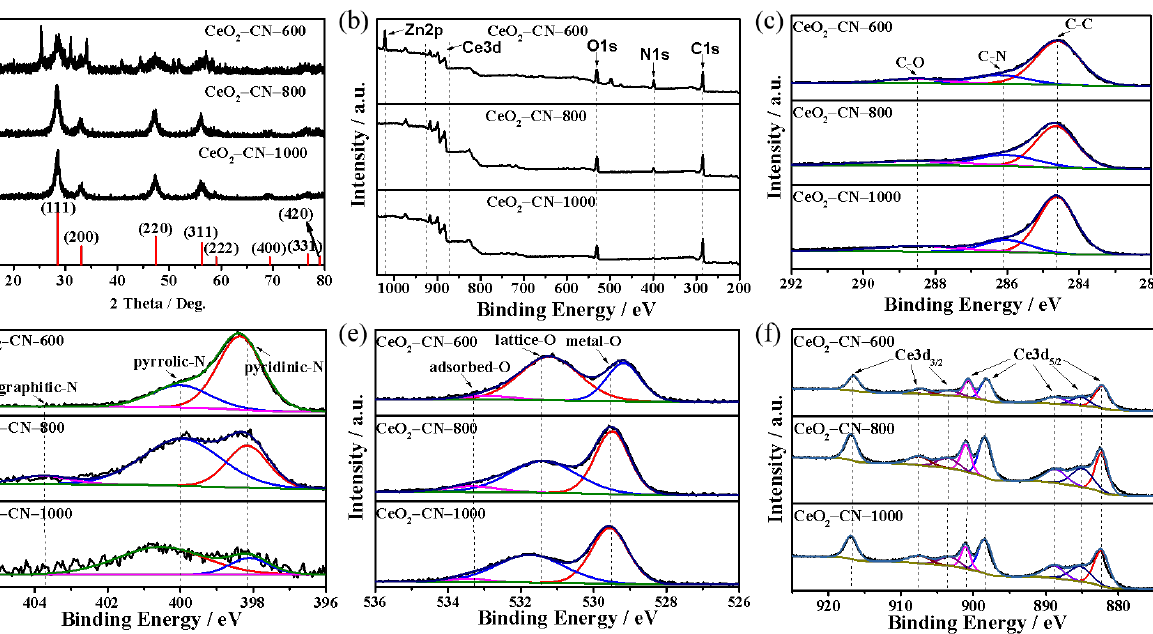
Figure 1. ( a – c ) SEM images of CeO 2 – CN calcined at 600, 800, and 1000 ℃ , respectively. ( d ) TEM image of CeO 2 – CN calcined at 800 ℃ . ( e – i ) High-angle annular dark field image and corresponding elemental mappings of CeO 2 – CN for C, N, O, and Ce, respectively.